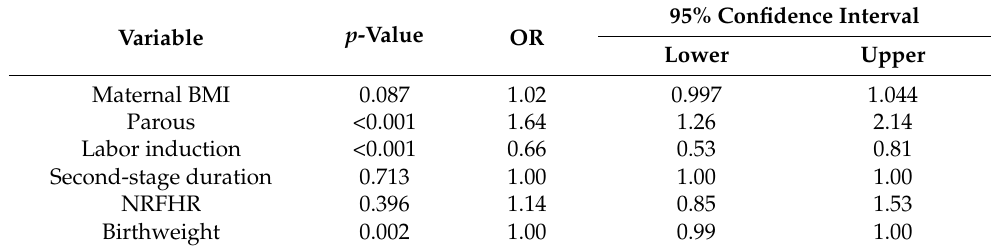
95% Confidence Interval Lower Upper